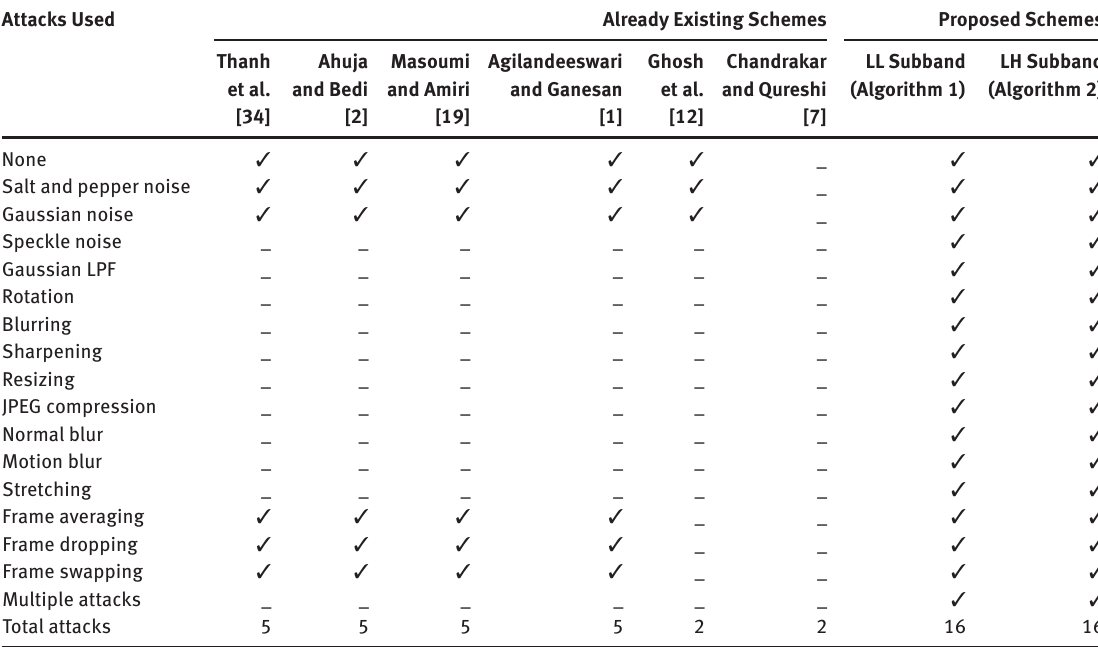
Table 15: Comparison between the Proposed Algorithms and Previous Work (Based on Attack). Attacks Used Already Existing